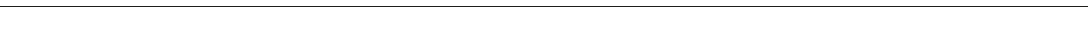
Fig. 5 cFP binding to the RIG-I CARD domain induces a conformational change to hinder its ubiquitination. a Neither cFP nor Phe-Pro interferes with RNA sensing by RIG-I. Immunoblotting analysis for RIG-I in the protein complex pull-downed by HCV 3 ′ -UTR, which was immobilized onto Streptavidin beads via the 17-mer biotinylated PNA-SL3-17 (Bi-PNA) targeting HCV 3 ′ -end X-RNA stem-loop III region, in the presence of the indicated peptides. b A pull- down experiment was performed as described in Fig. 3a, with non-stimulated HEK293T cells that transiently expressed the Flag-tagged RIG-I CARD region. c , d HEK293T cells, which transiently expressed Flag-tagged RIG-I CARD region without ( c ) or with an HA-tagged ubiquitin (HA-Ub) ( d ), were left untreated or treated with cFP or Phe-Pro, prior to quanti fi cation of IFN- β mRNA levels ( c ) and immunoblotting analysis for the indicated proteins ( c , d ). Shown on the right panel in d are immunoblots of whole cell lysates (WCL). e , f HEK293T cells, which transiently expressed an HA-tagged ubiquitin for 12 h, were stimulated by intracellular delivery of HCV 3 ′ -UTR RNA (1 μ g ml − 1 ) ( e ) or S-poly(I:C) ( f ) by liposome-mediated transfection and further incubated with 2.5 mM cFP for 6 h, prior to immunoblotting analysis for the indicated proteins as in d . g Limited trypsin digestion of RIG-I was performed in the presence of HCV 3 ′ -UTR RNA for the indicated reaction times. Cleaved fragments of RIG-I were subjected to SDS-PAGE and visualized by immunoblotting with polyclonal antibody against full-length recombinant human RIG-I. Predicted molecular masses of cleaved RIG-I fragments [amino acid positions are numbered according to the GenBank sequence (NP_055129.2)] are shown